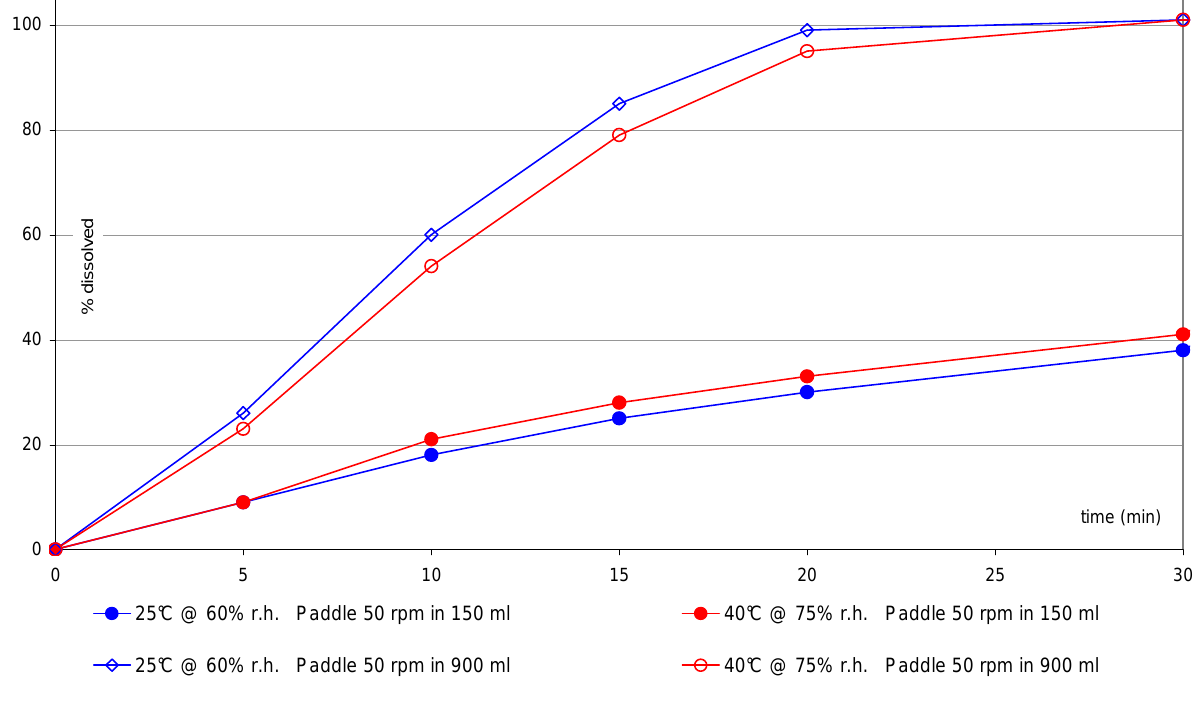
Figure 8. IR(2) tablets: comparison after storage using small vessel accessories.